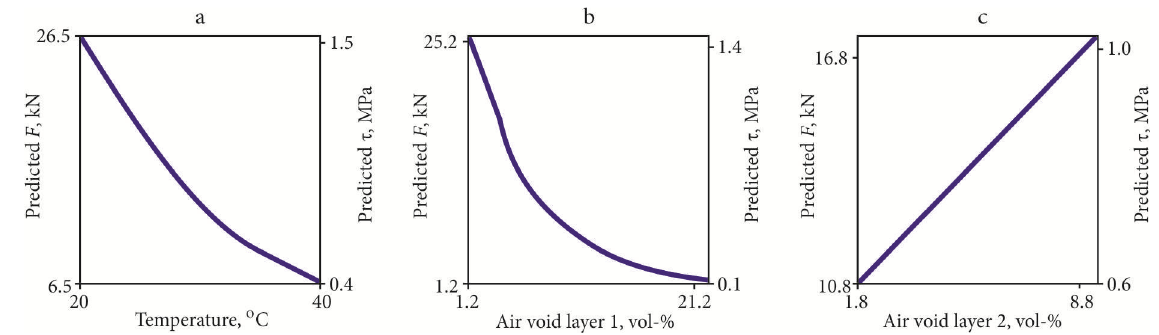
Fig. 10. Response graphs of the input variables as a function of F max and τ max : a – temperature; b – air void content layer 1; c – air void content layer 2